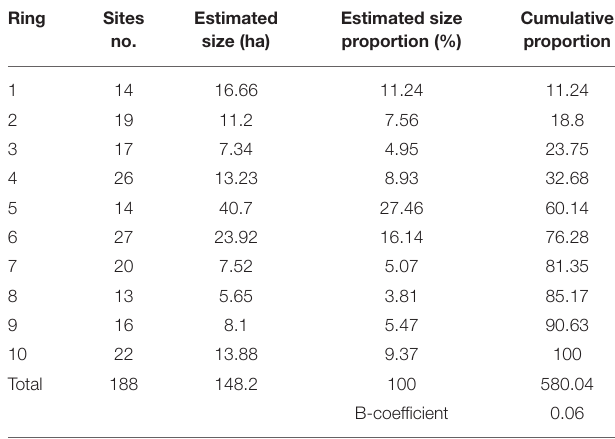
Cumulative proportion